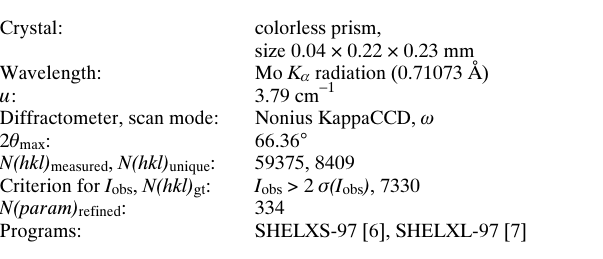
Table 1. Data collection and handling.